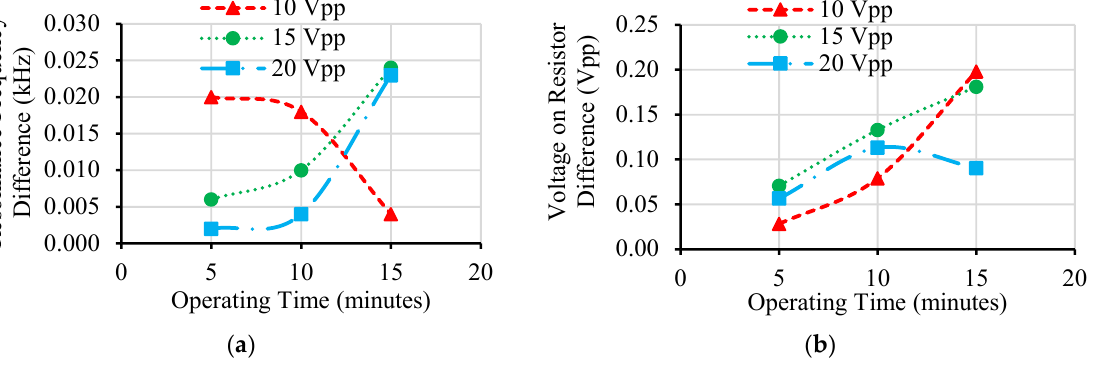
Figure 13. Operating time and input voltage effects over; ( a ) The variation of the resonance frequency; and ( b ) The variation of the resistor voltage for T2 transducer.